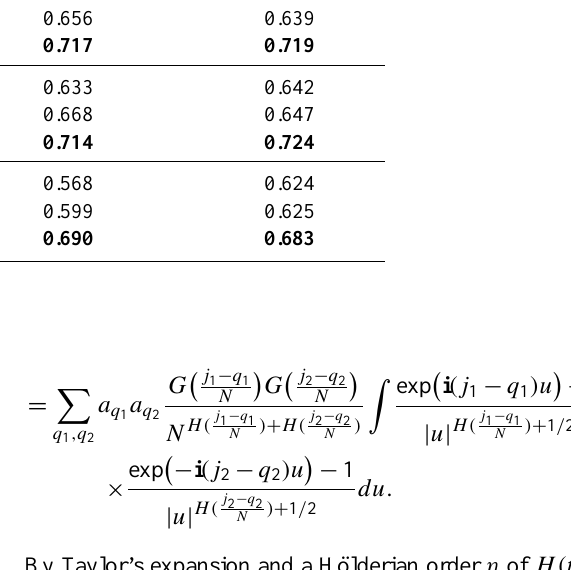
Table 5. Average correct classification rates through five thousand partitions of the total 103 runs into training (70%) and testing (30%) sets are shown for the classification methods (LDA, QDA, SVM), the estimation methods ( WV , LC , GC ), and the chosen descriptors. chosen descriptors Var ˆ , Avg ˆ H,u 1